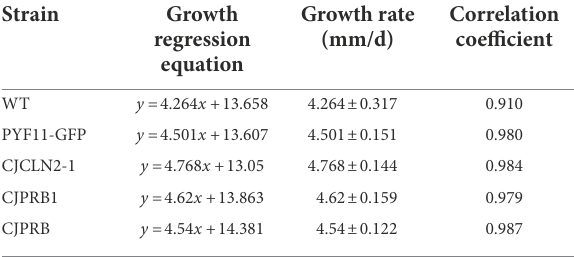
TABLE 4 Regression equations of colony growth of different strains of C . javanica BE01 on SDAY medium (mean ± SE). Strain Growth regression